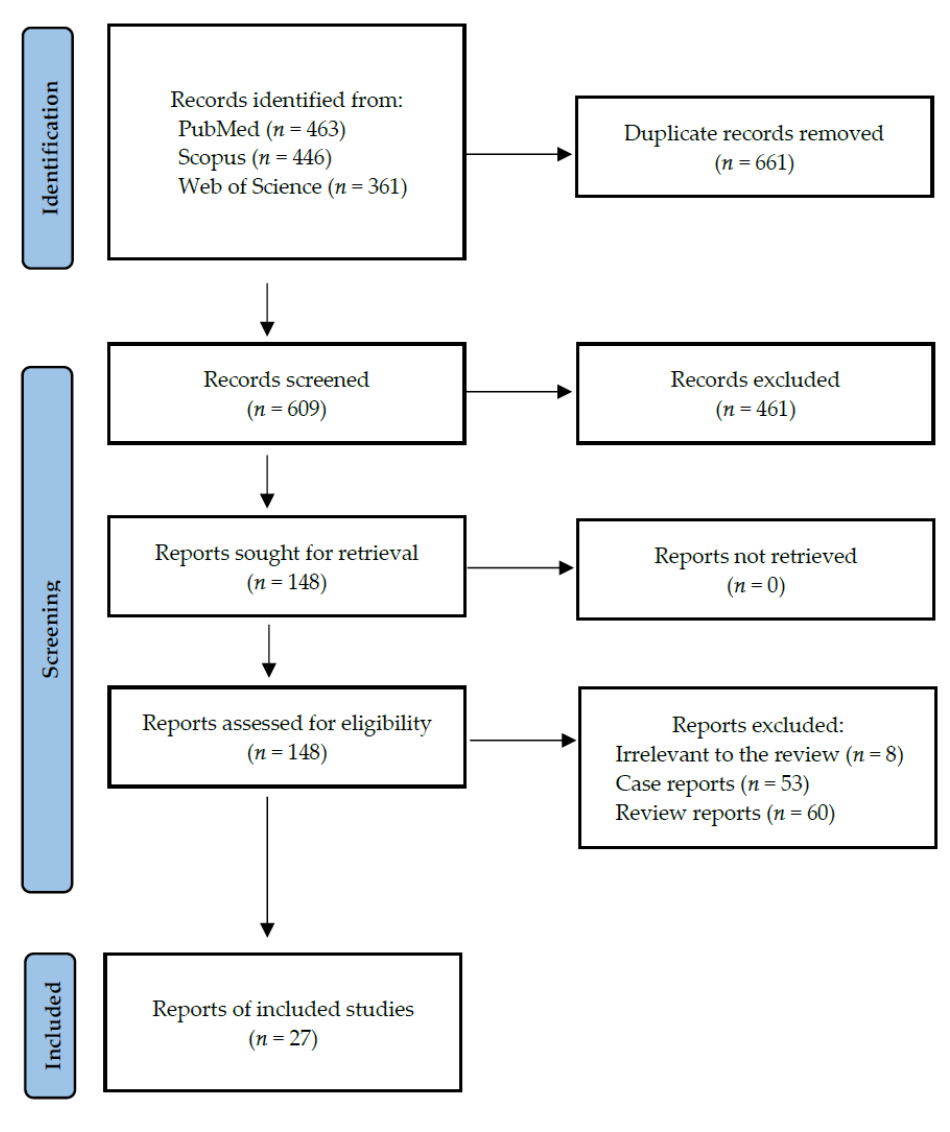
Figure 2. PRISMA flow diagram presenting search strategy.